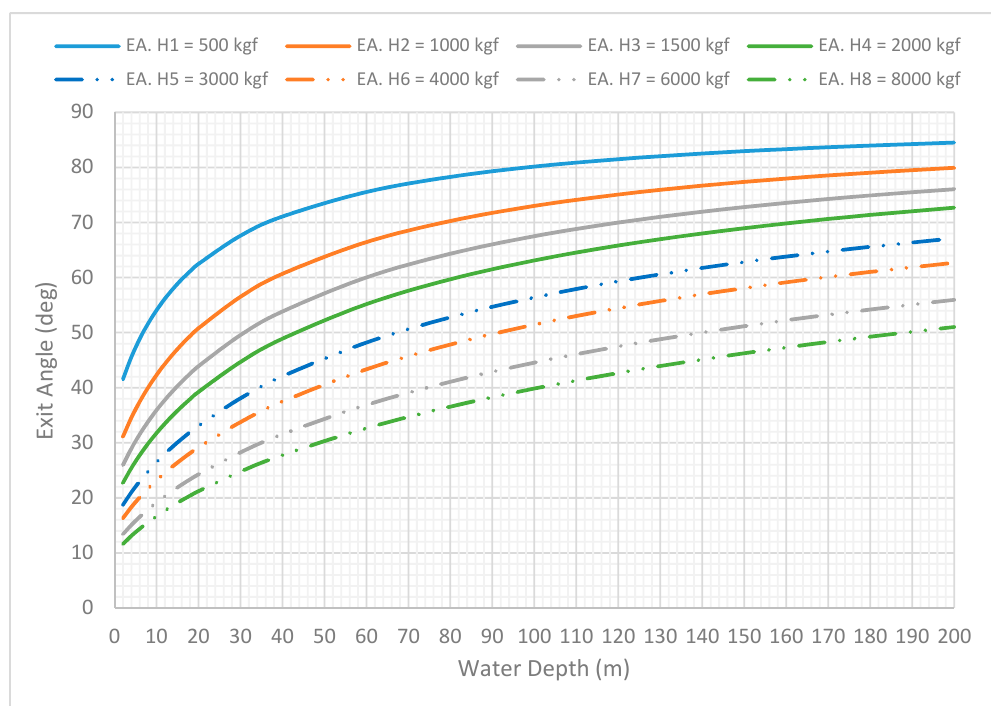
Figure 6. Exit angle ( θ ) using various bottom tension values (500 kgf–8000 kgf) and water depths (2 m–200 m).